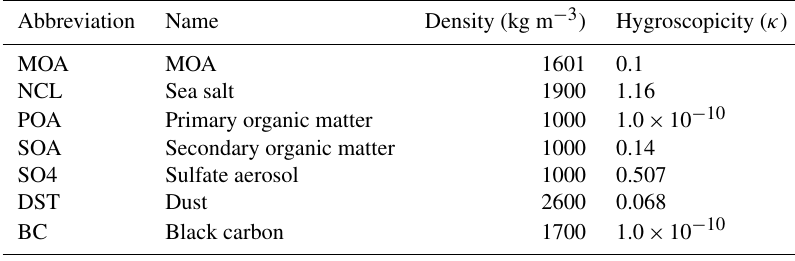
Table 1. Aerosol species and material properties used in the model simulations.